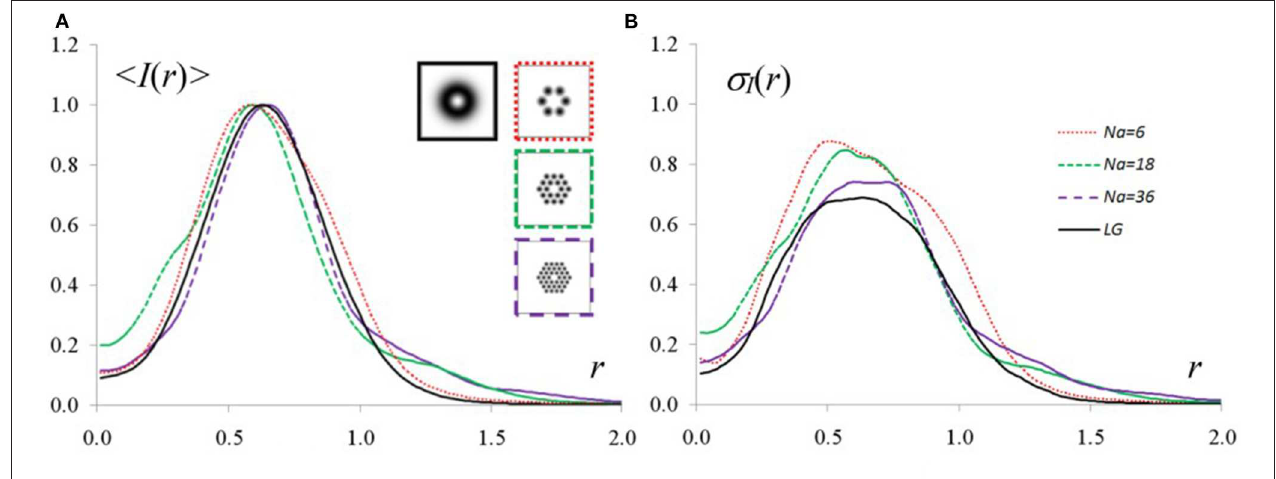
FIGURE 11 | Distribution of the average intensity (A) and relative variance of intensity fluctuations (B) at the propagation of the traditional and synthesized vortex beams in the turbulent atmosphere. The beam parameters and propagation conditions are the following: l diameter, r 0 =